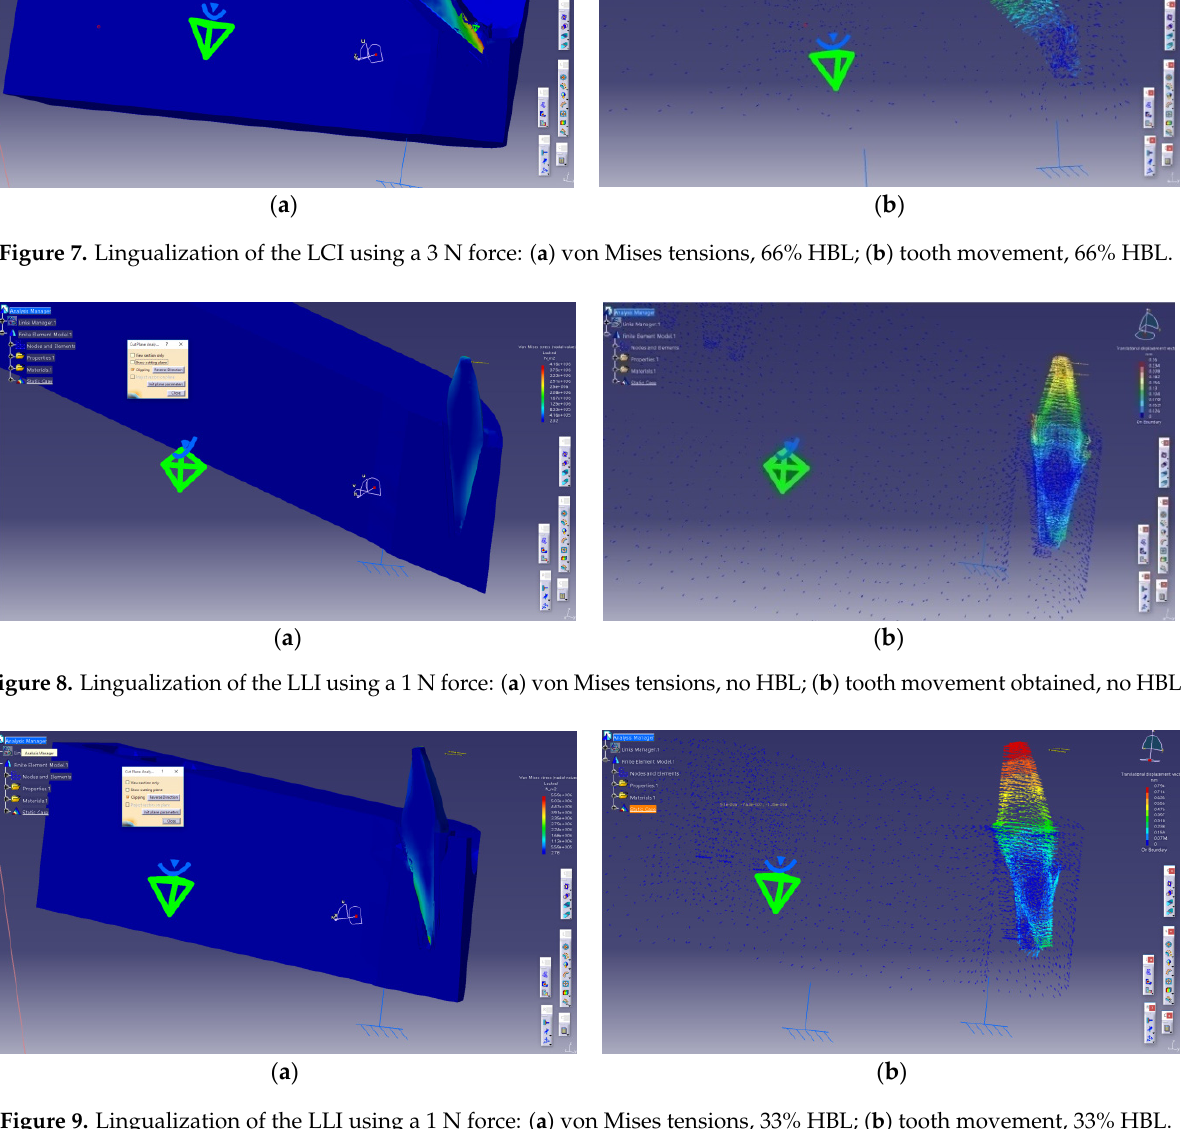
Figure 7. Lingualization of the LCI using a 3 N force: ( a ) von Mises tensions, 66% HBL; ( b ) tooth movement, 66% HBL.